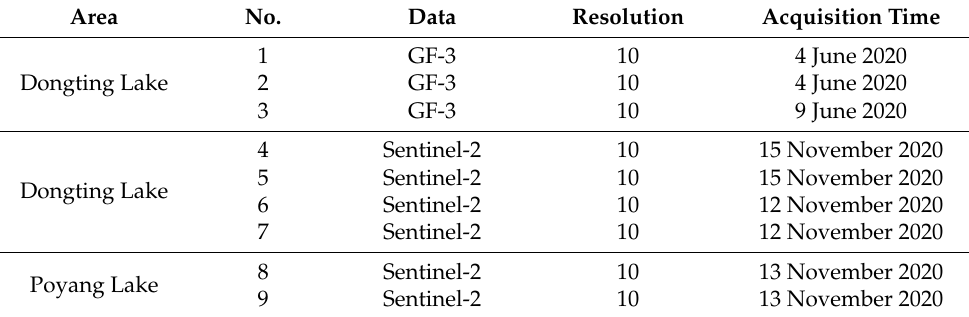
Table 2. Basic information of auxiliary